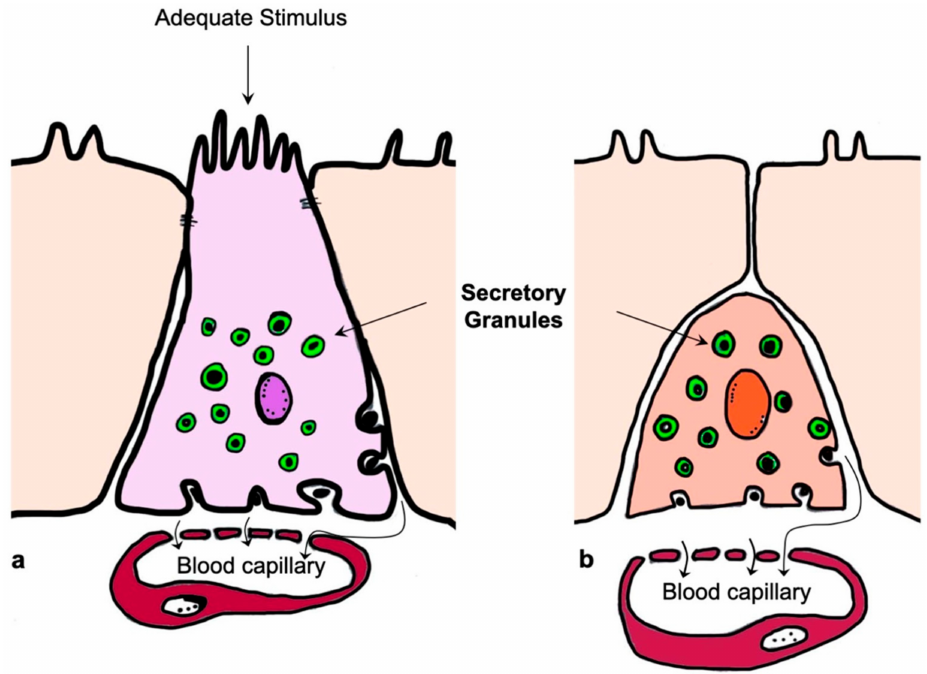
Figure 2. Schematic representation of the enteroendocrine cells; open ( a ) and closed ( b ) type. Modified from Sundler et al., 1989